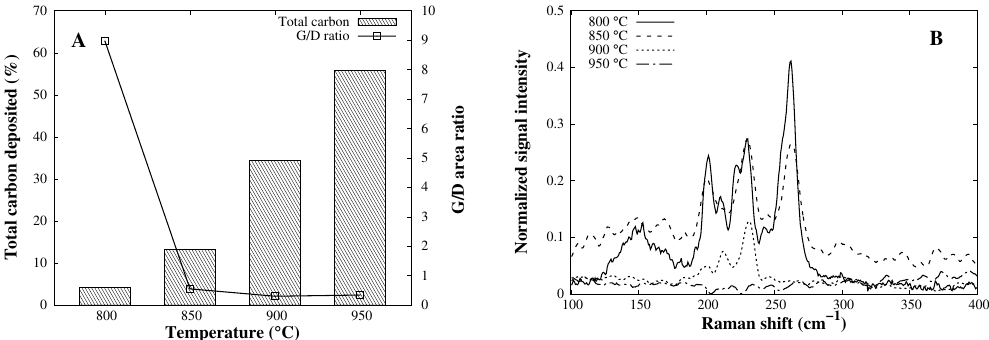
Figure 7. ( A ) Total mass content of carbon and the G to D area ratio of CVD products and ( B ) the RBM distribution of CVD